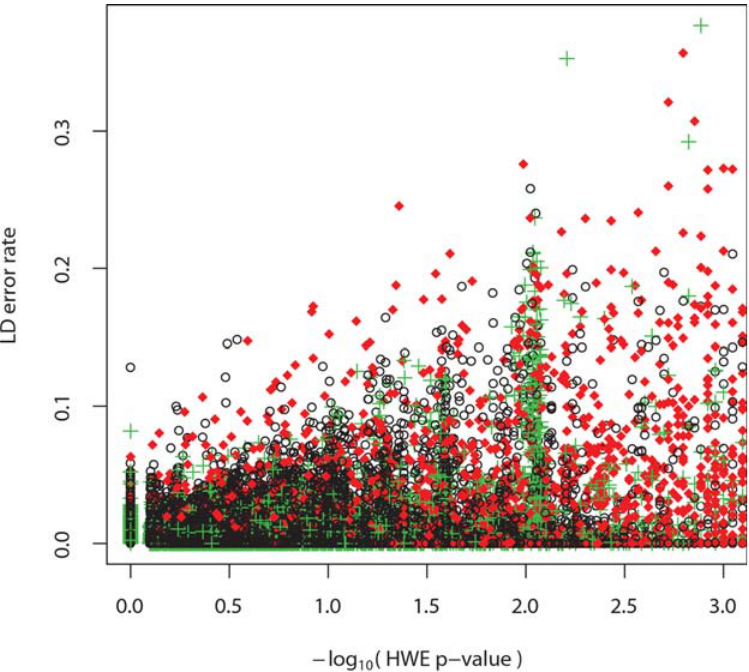
Figure 3. LD-based error rate vs. HWE. An LD-based error rate was estimated and a test of HWE (PEDSTATS [13]) was conducted for data from chromosome 7 HapMap CEU unrelated samples at each of the following types of SNPs: passed all HapMap QC criteria and had zero MIs (black # ); passed QC criteria with exactly one MI (green + ); and failed due to the presence of multiple MIs (red ¤ ). SNPs which failed QC due to extreme deviations from HWE are